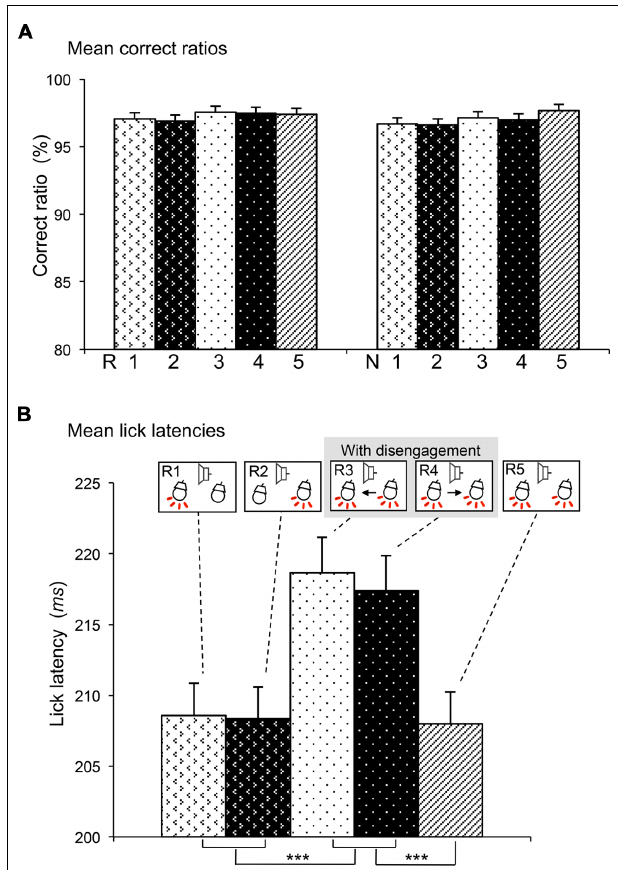
FIGURE 2 | Comparisons of correct ratios in the reward and non-reward trials (A) and lick latencies in the reward trials (B) among the five sessions. (A) There was no significant differences in correct ratios (two-way ANOVA, P > 0.05). R1–5, reward trials in sessions 1–5; N1–5, non-reward trials in sessions 1–5. (B) Lick latencies were significantly longer in sessions 3 and 4 than other sessions. ***significant difference from sessions 1, 2, and 5 (Bonferroni test after one-way repeated measures ANOVA, P < 0.001).The behavioral data were collected during the recordings of 156